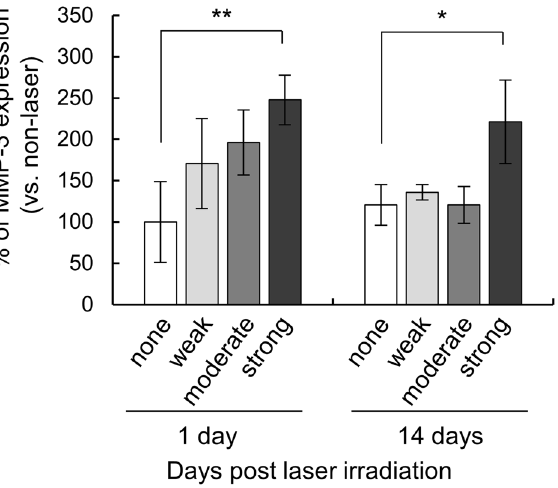
Figure 5. Long-term protein expression of MMP-3 after MP-laser irradiation. Protein levels of MMP-3 in the culture medium were measured by ELISA 1 or 14 days after laser irradiation (n = 3). Data are represented as mean ± standard deviation of the mean. * P < 0.05, ** P < 0.01, *** P < 0.001 by Dunnet’s multiple comparisons test.